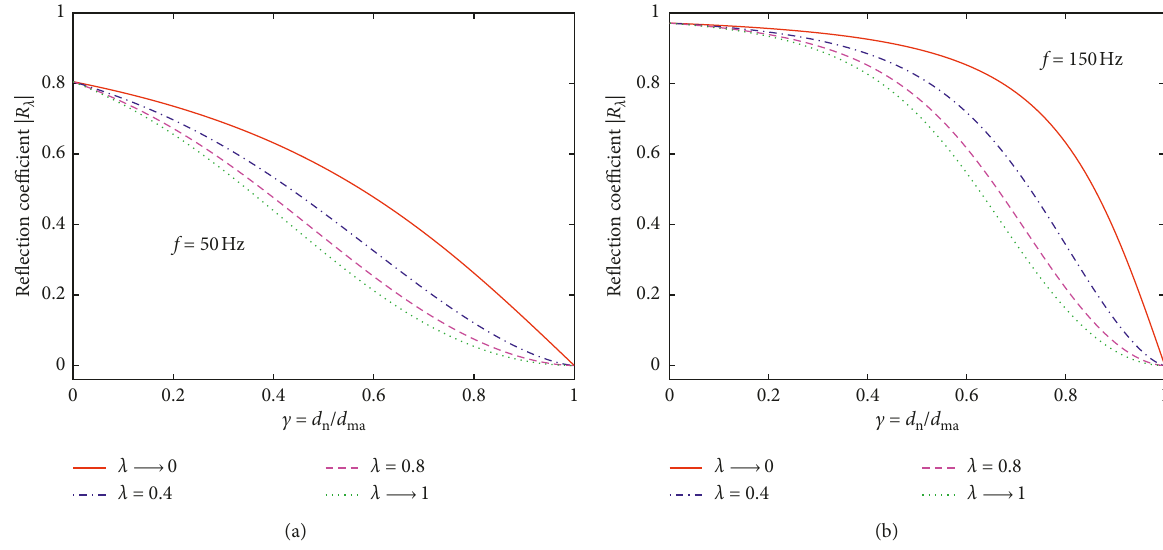
R λ | as a function of |